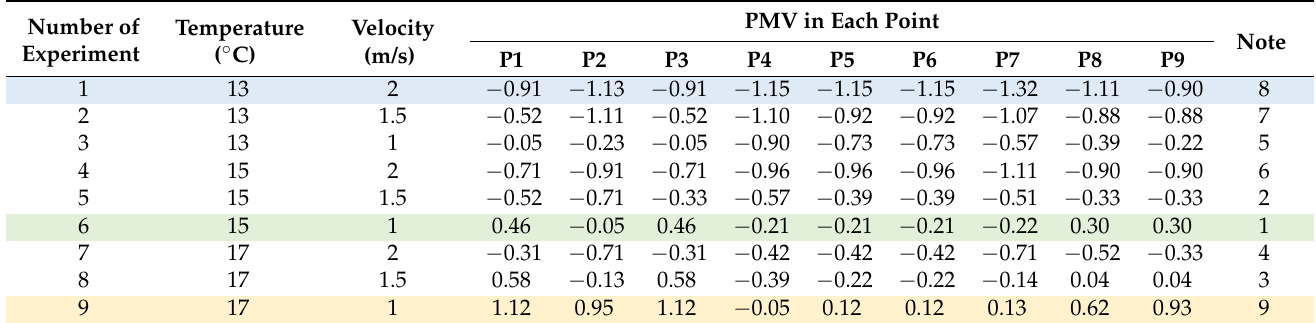
Table 3. Experiment results of the indoor environment for the thermal